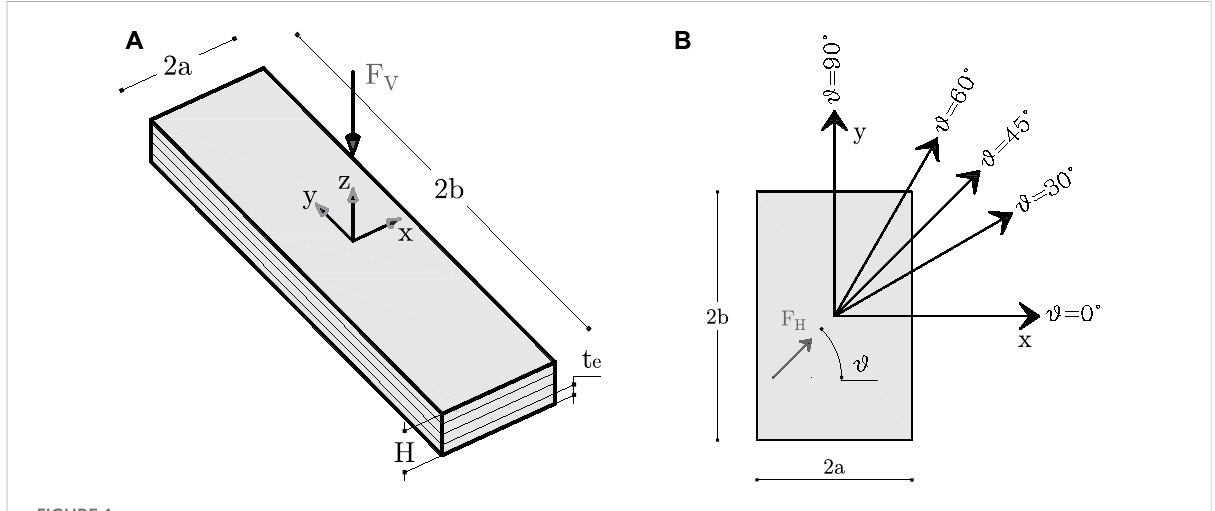
FIGURE 1 U-FREI studied: (A) geometric parameters de fi nition, (B) horizontal loading directions.